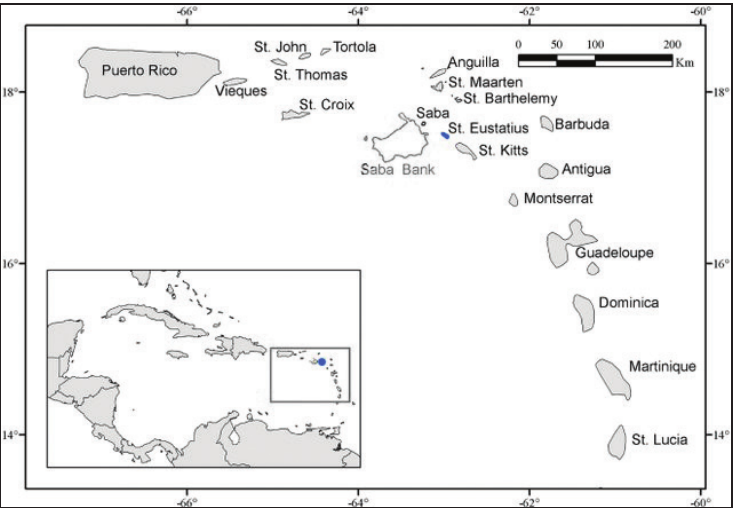
Figure 1. Location of Sint Eustatius. The Caribbean Sea, with the location of Sint Eustatius island indi- cated in the inset. Source: Hoetjes and Carpenter (2010: fig. 1).